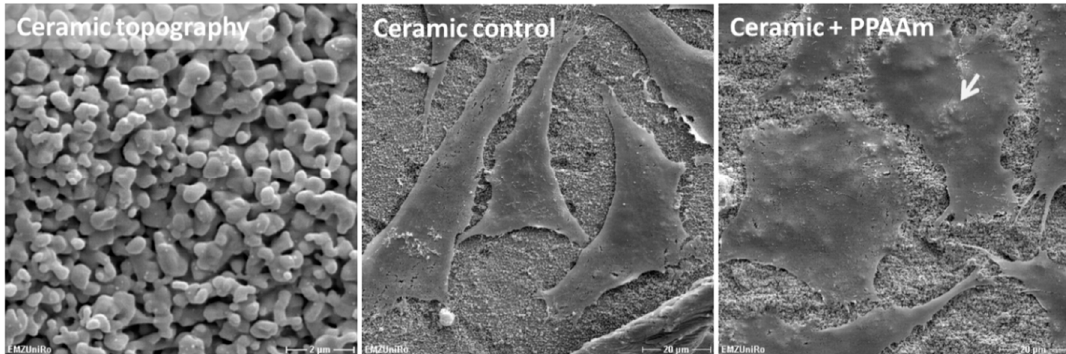
Figure 11. Cell morphology on plasma polymer (PPAAm)-modified rough ceramic after 24 h. The cell area on PPAAm (960 s gross) is increased and the cells melt into the underlying ceramic topography (arrow) in a way that the surface structures can be seen on the cell surface. (SEM DSM 960A, scale bars: left = 2 µm; middle and right = 20 µm, no. BK052).